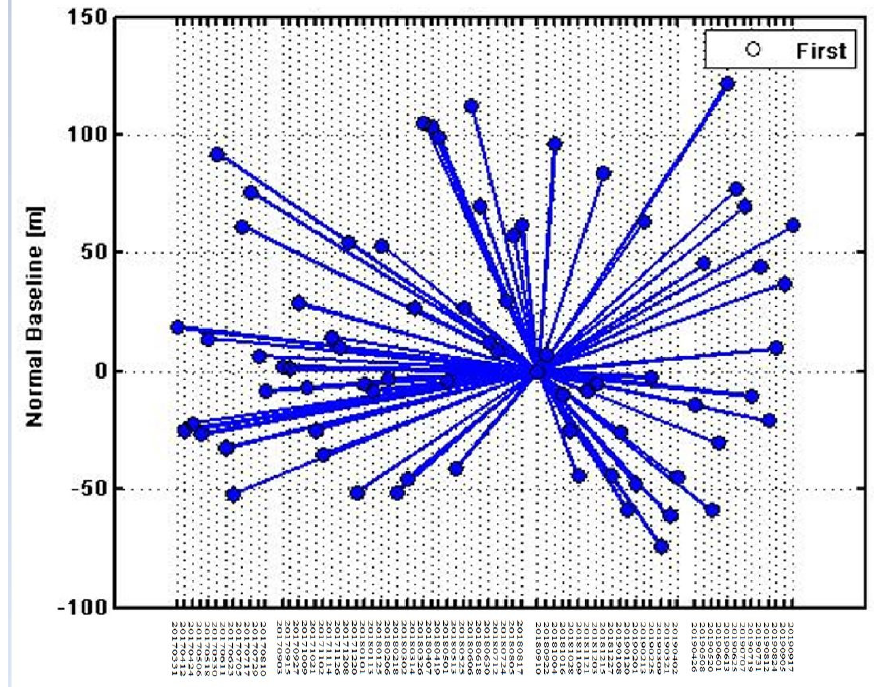
Figure 4. Star graph showing temporal/perpendicular baseline distribution of data pairs.